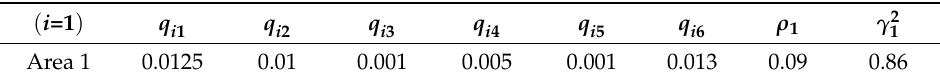
Table 2. Parameters of controller design for Control Area 1.